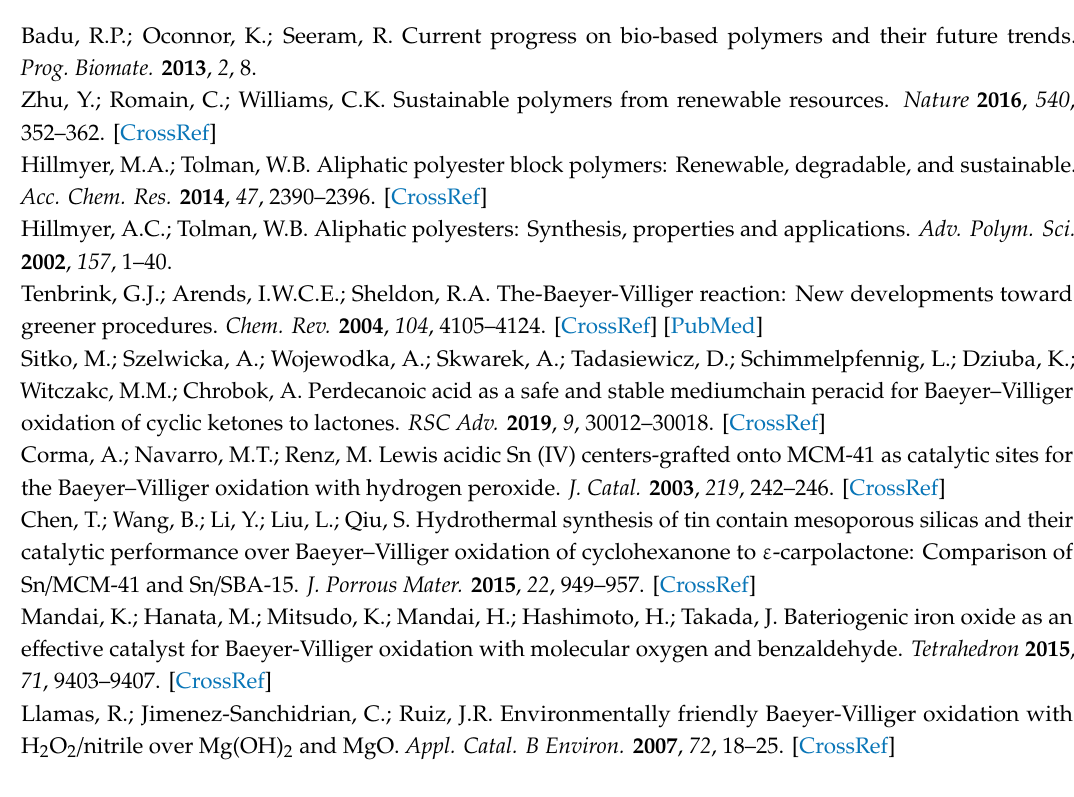
Figure S1: 1 H NMP of COOH-IL and COOH-PIL, Figure S2: GC-MS Spectra of Cyclopentanone Oxidation Product, Figure S3: GC-MS Spectra of Cyclohexanone Oxidation